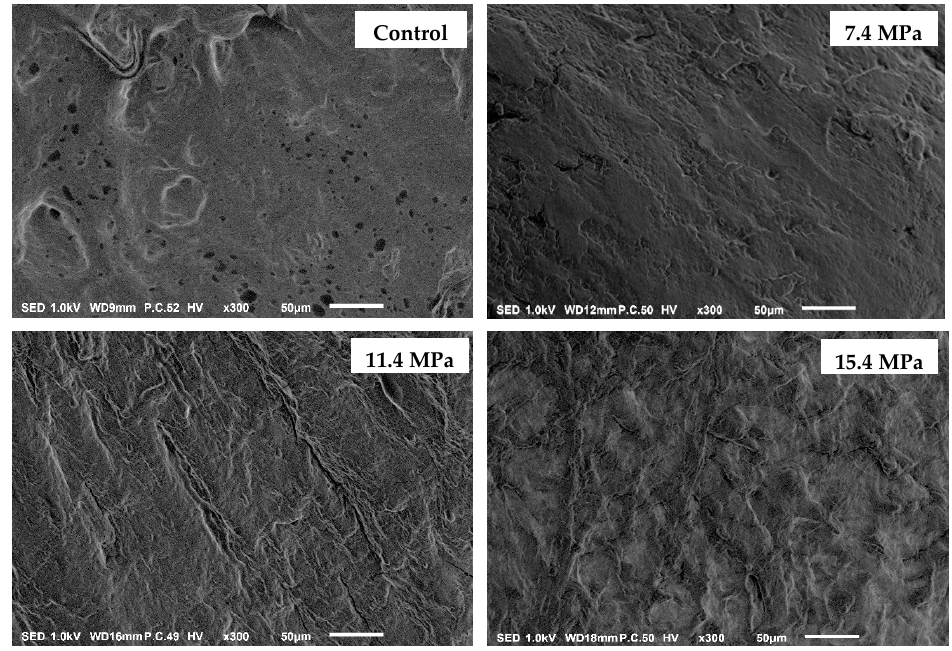
Figure 1. The microstructure (300× magnification) of raw chicken meat (zeroth day storage) treated with SC-CO 2 at three levels (7.4, 11.4 and 15.4 MPa) at 31 °C for 10 min.